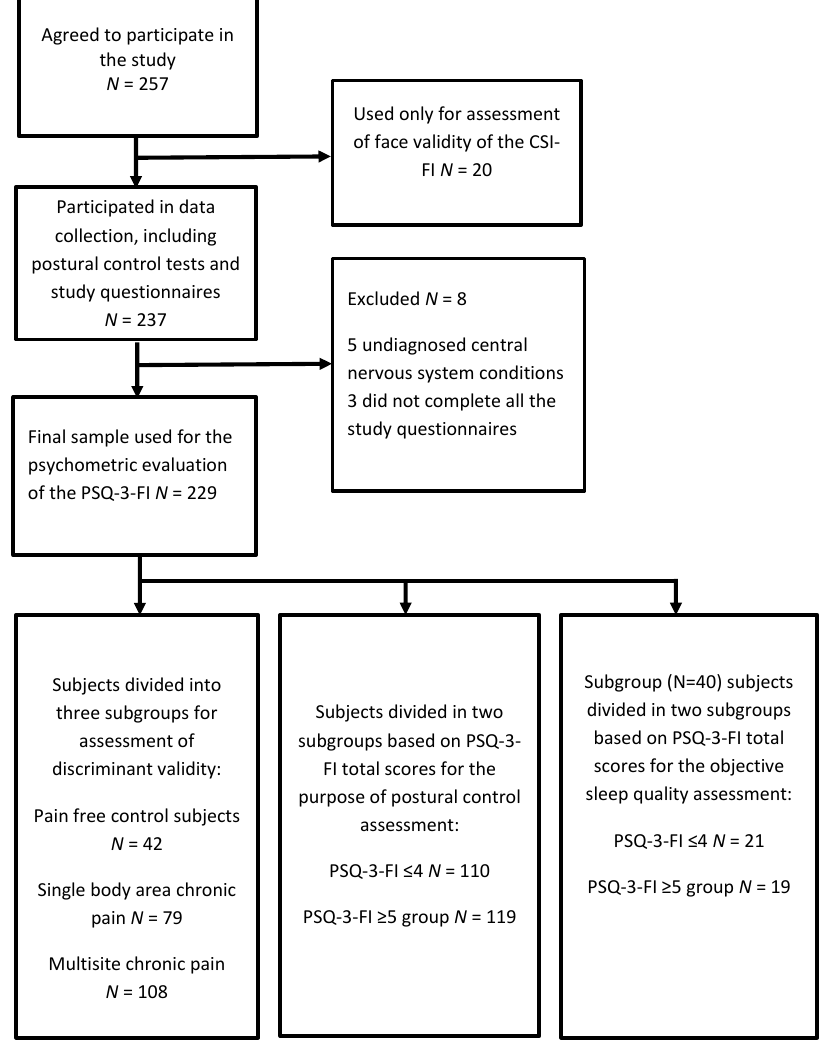
Figure 1. Flow chart of subjects. Table 1. Mean Pain and Sleep Questionnaire three-item index (PSQ-3-FI)